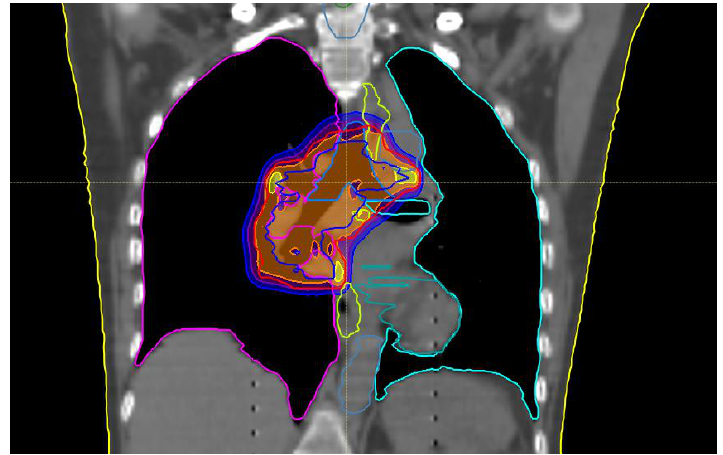
Figure 1. Treatment plan for mediastinal relapse.